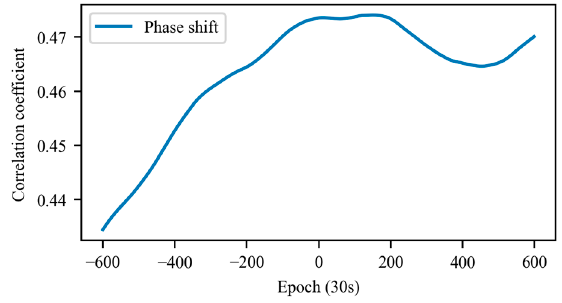
Figure 8. Correlation coefficients between the PWV and rainfall.